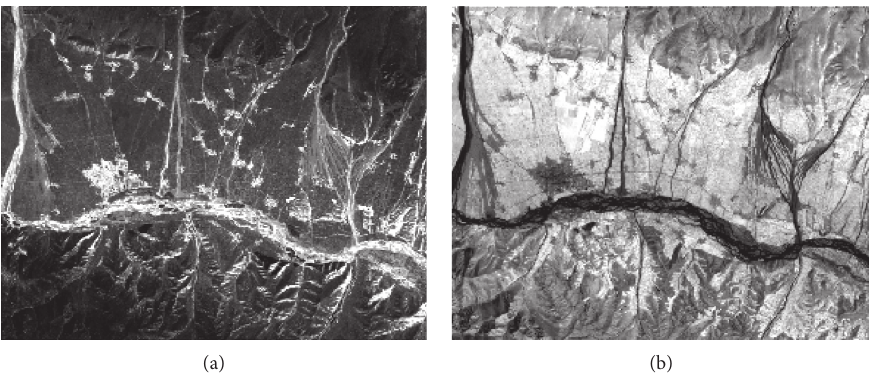
Figure 2: (a) 45th band grayscale image. (b) 49th band grayscale